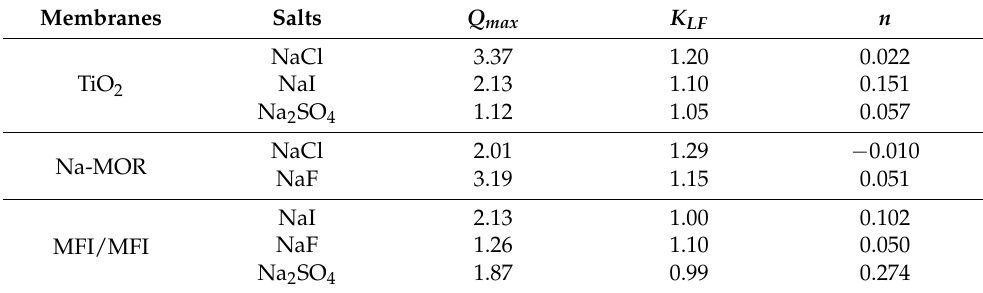
Table 2. Parameters of the Langmuir–Freundlich isotherms obtained with the various salts and